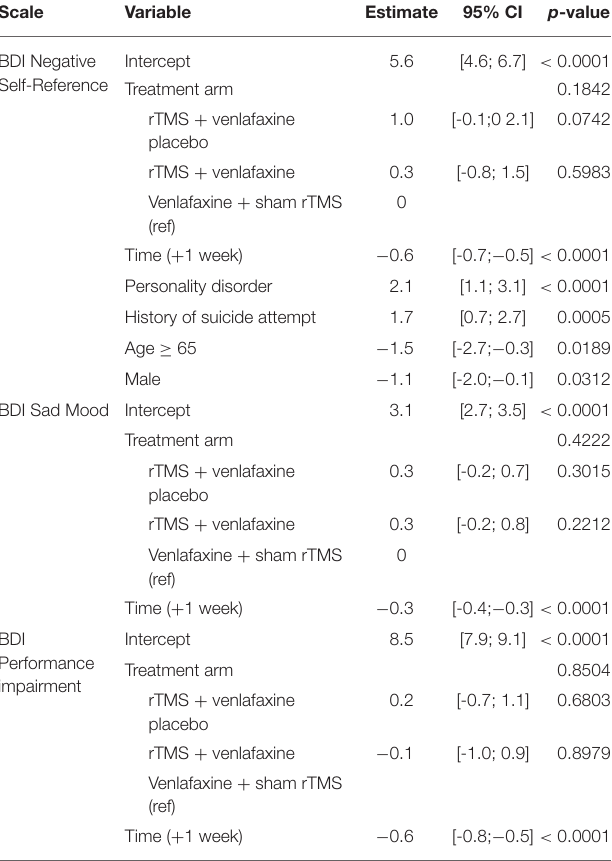
TABLE 2 | Estimates of the fixed effects of linear mixed models with correlated intercept and random slope for the 3 domains of the BDI 13 , N = 170. Scale